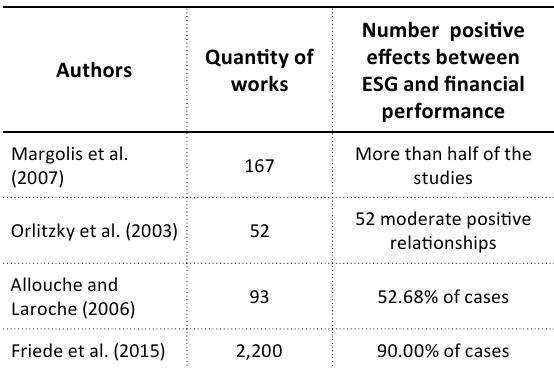
Table 2. Meta-studies of responsible